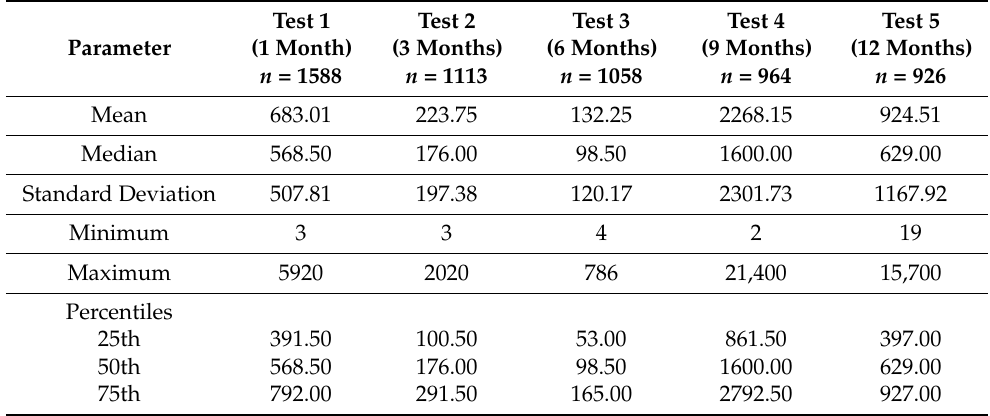
Table 2. Antibody concentrations for each test taken at 1, 3, 6, 9, and 12 months after full (two doses) BNT162b2